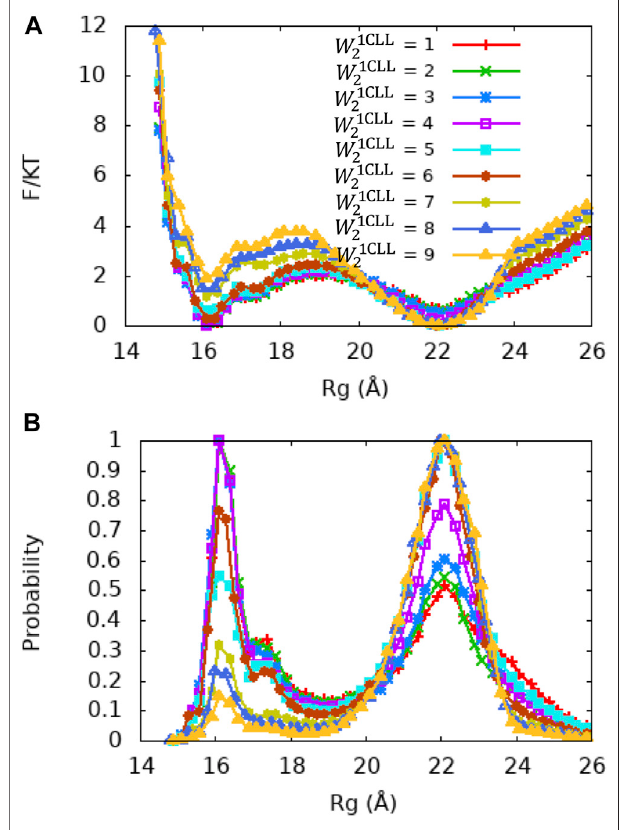
FIGURE 6 | PMF and Rg distribution of the Ca 2+ -CaM models for differentvaluesofthelocalmemoryweight W 1CLL n (n (cid:1) 2)forthecentrallinkerof CaM. The memory weight parameters of the Ca 2+ -CaM models are listed in Table 2 model III; λ FM (cid:1) 0 . 1, W others n The reweighted free energy pro fi le as a function of Rg from US simulations (B) and the probability distribution as a function of Rg. The standard errors in the PMF are provided in Figure S7 in the